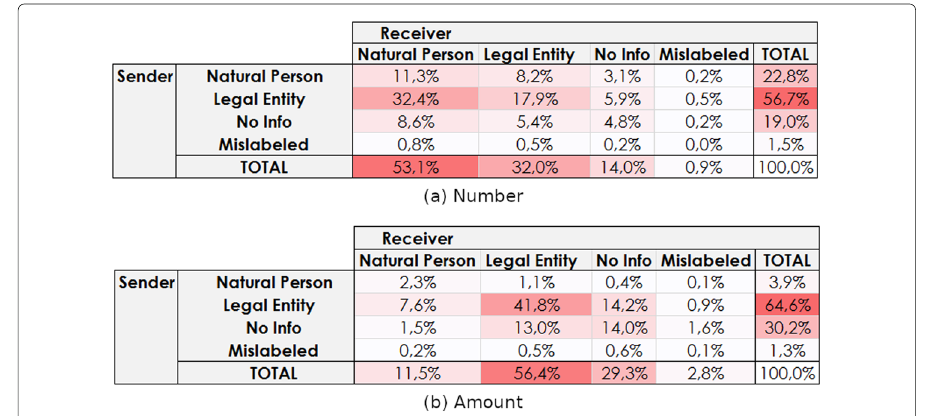
Fig. 2 Distribution of wire transfers by number (top) and amount (bottom): the highest overall amount is transferred from legal to legal entities, even if the majority of wire transfers are from legal to natural persons